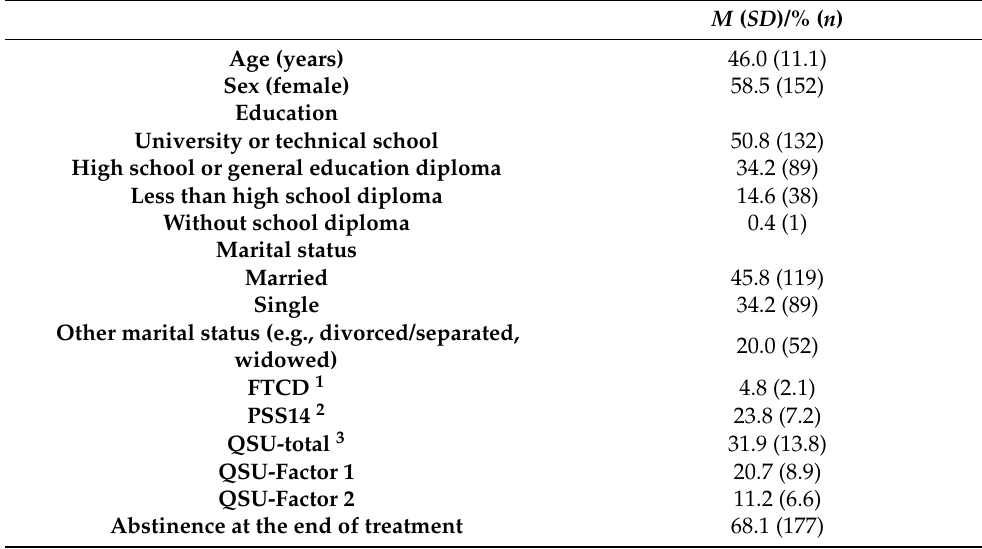
Table 1. Descriptive data of the study variables.